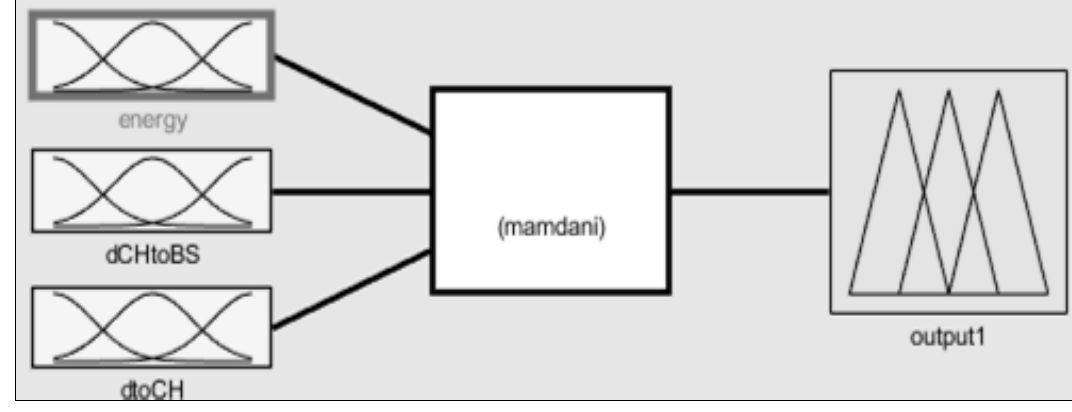
Figure 8. Second FIS for cluster configuration.